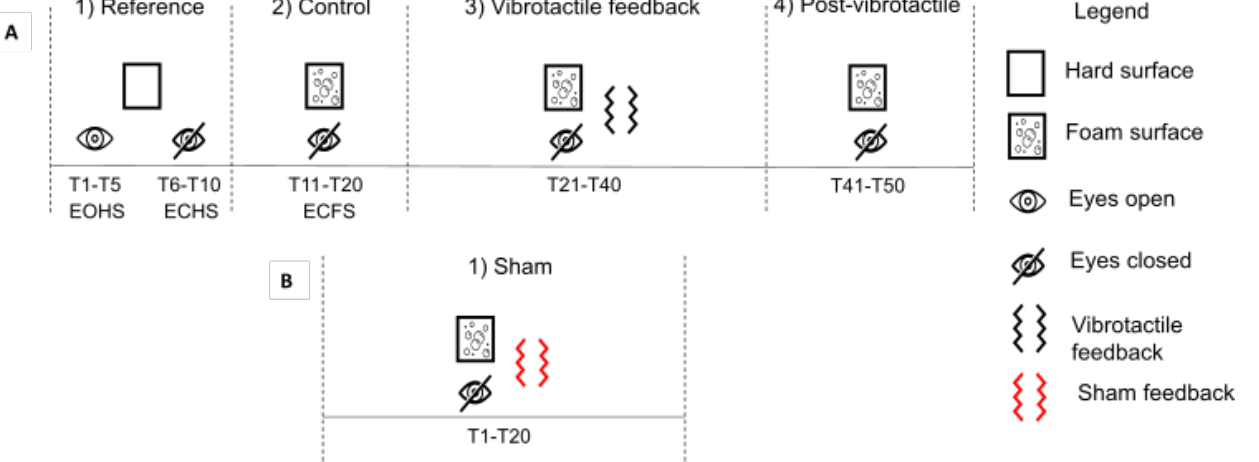
Figure 4. Experimental protocol. There were five conditions divided into two phases ( A , B ). Trials were either performed with eyes opened or closed while standing on a hard or foam surface. In addition, the participants had either no vibrotactile feedback (reference, control, and post-vibrotactile), vibrotactile feedback related (vibrotactile feedback) or unrelated (sham) to body sway direction. The order of the trials in each condition is indicated for each condition (i.e., T refers to trial, T first trial — T last trial).